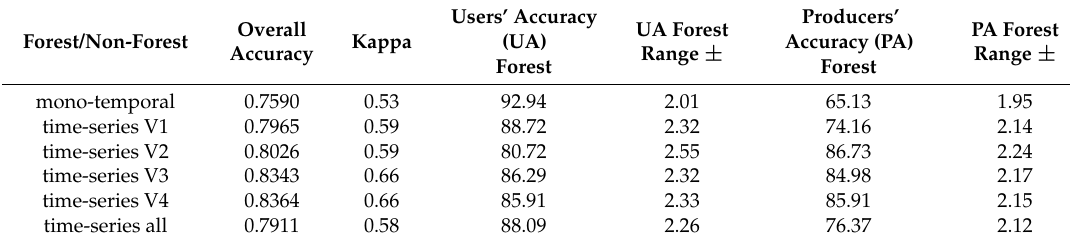
Table 3. Accuracies of mono-temporal versus time series approach for FNF